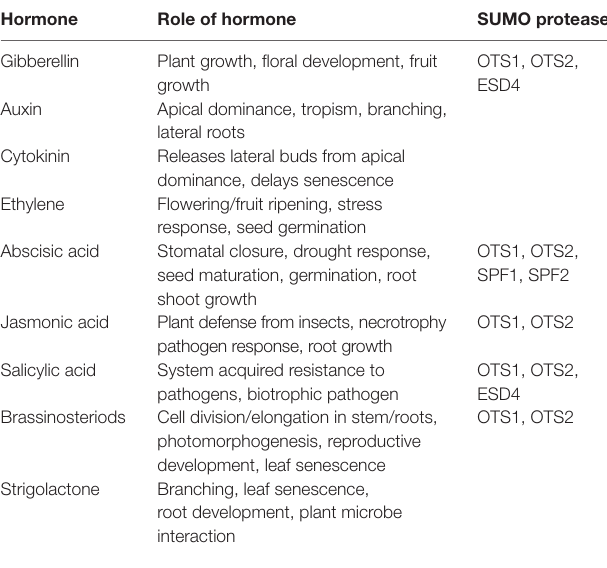
where SUMO proteases have not currently been identified to have a role, which may be a research